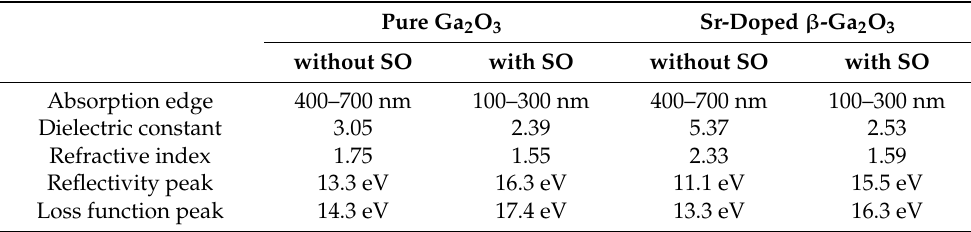
without SO with SO